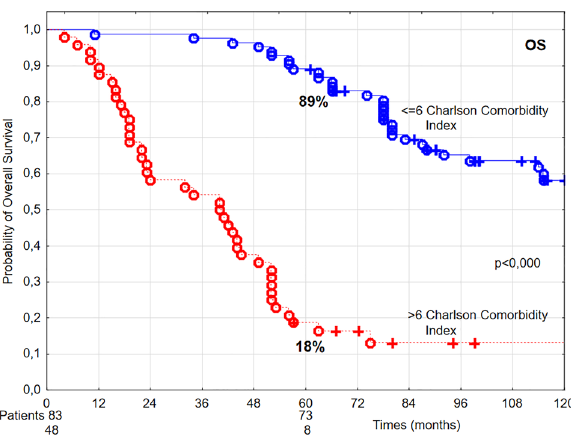
Figure 5. The probability of 5-year overall survival (OS) in T1 glottic cancer patients aged 70 and above in relation to the Charlson Comorbidity Index.